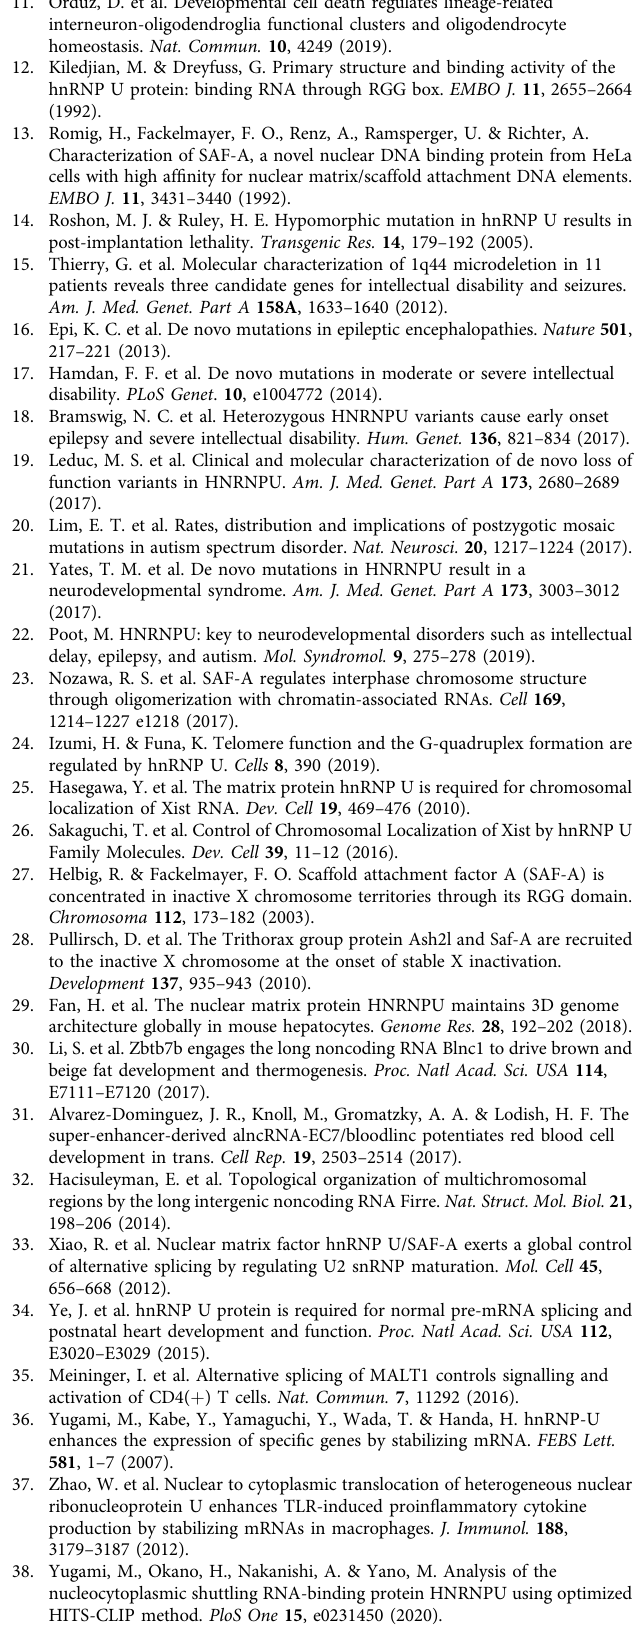
Supplementary information table 1: primary antibodies list. Supplementary information table 2: secondary antibodies list. Supplementary information table 3: chemical list. Supplementary information table 4: media. Supplementary information table 5: kits. Supplementary information table 6-: oligonucleotides. Supplementary information table 7: recombinant DNA. Supplementary information table 8: softwares. Reporting summary . Further information on research design is available in the Nature Research Reporting Summary linked to this